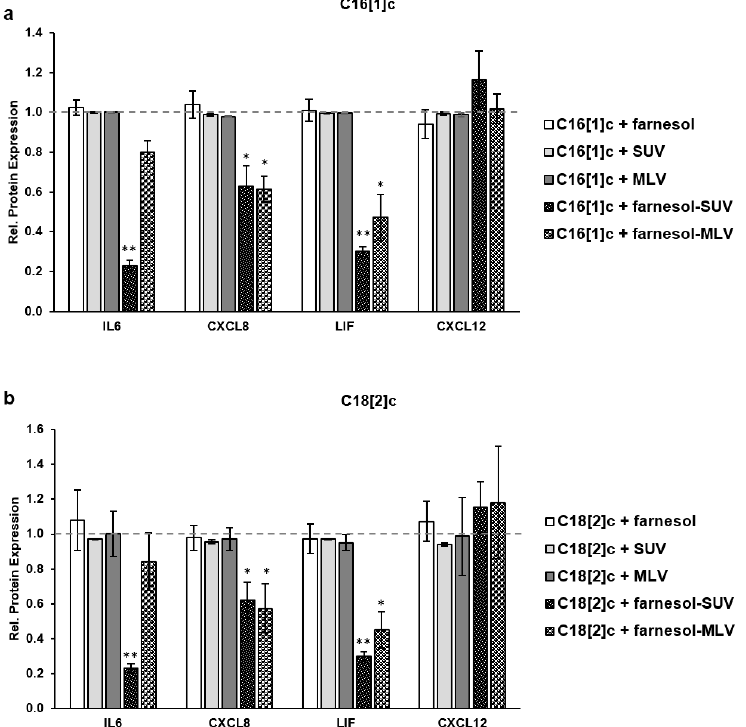
Figure 5. Farnesol inhibits the FFA-induced expression of inflammatory proteins. SkMs were left untreated or treated with farnesol, SUV, MLV, farnesol-SUV, or farnesol-MLV for 24 h; ( b ) SkMs were washed and treated with C16[1]c ( a ) or C18[2]c ( b ) or left untreated for 48 h. SkM extracts were then analyzed using multiplex cytokine quantification assays thrice. The relative protein expression was obtained by comparing the level of each marker in farnesol-, or liposome-treated cells to its expression level in FFA-stimulated cells (C16[1]c in 5a and C18[2]c in 5b), which was set to 1 (dashed gray lines, Figure 5a,b). The mean values ± SD from three independent experiments are presented (Supplementary Materials, Figure S6). Statistical significance was calculated using one-way ANOVA with Bonferroni’s multiple comparison test. p ≤ 0.05 (*). p ≤ 0.01 (**).